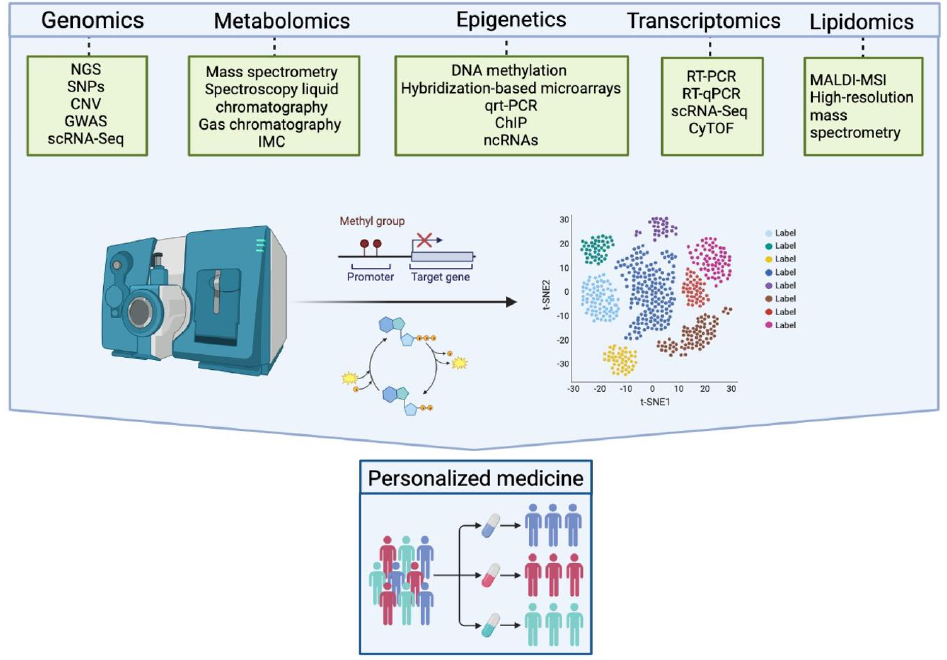
Figure 3. Multiomics technologies. The use of omic methods can be applied in DNA, RNA, proteins, lipids, and metabolites, among others, allowing expansion of knowledge of immune-mediated dis- eases to approach personalized medicine. NGS: next generation sequencing; SNP: single nucleotide polymorphisms; CNV: cellular number variations; GWAS: DNA copy number analysis; genome- wide association; scRNA-Seq: single-cell RNA Sequencing; IMC: imaging mass cytometry; qRT- PCR: quantitative reverse transcription PCR; ChIP: chromatin immunoprecipitation ; ncRNAs: his- tone modification and non-coding RNAs; RT-PCR: reverse transcription polymerase chain; CyTOF: single-cell with mass cytometry; MALDI-MSI: matrix-assisted laser desorption ionization mass spectrometry imaging. 7. Conclusions Because PsA is a complex, systemic, and heterogeneous disease in which multiple tissues and clinical domains are involved, there is a need to base disease diagnosis, clas- sification, and management on the immunophenotypic basis of clinical domains at the tissue level, rather than clinical manifestations alone [184]. Interestingly, the experts re- vising unmet needs in PsA agree that “investigation of domains where tissue biopsy is not straightforward to obtain (e.g., entheses or spine), then ‘molecular imaging’ (e.g., ad- vanced PET) with granular probes for specific cell types could help contextualize disease endotypes” [185]. In fact, we already have a successful example of the application of FAPI- PET imaging in the cellular and molecular understanding of bone damage in PsA [68]. Another area identified for improvement is the diagnosis and definition of “ early PsA” or “ pre- PsA” to facilitate treatment trials designed with the goal of preventing or early eradication of disease, which is ongoing with the PAMPA trial [186]. In addition, following the example of RA, new designs of molecular pathology-driven clinical trials in